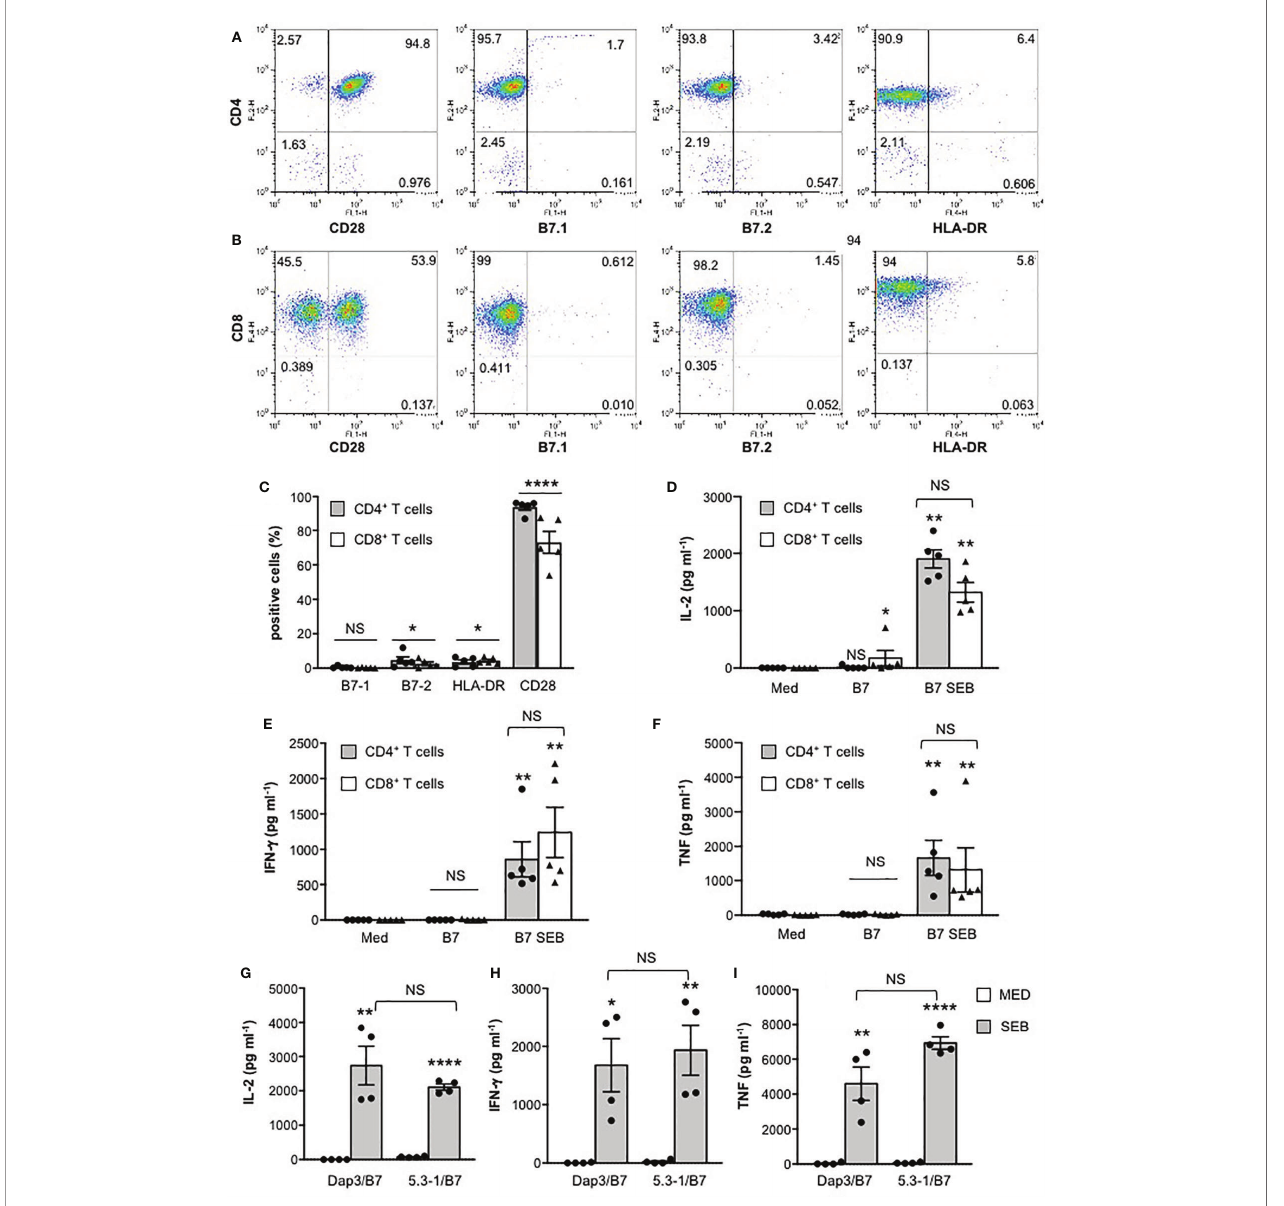
FIGURE 3 | MHC class II molecules are dispensable for SEB-induced in fl ammatory cytokine production in human primary CD4 + and CD8 + T cells. (A, B) Human CD4 + T cells (A) or CD8 + T cells (B) were isolated from the peripheral blood of healthy donors (HD). One representative FACS analysis of human CD4 + T cells stained with anti-CD4-PE plus anti-CD28-FITC or anti-B7.1-FITC or anti-B7.2-FITC or anti-CD4-FITC plus anti-HLA-DR-APC (A) , or human CD8 + T cells stained with anti-CD8-APC plus anti-CD28-FITC, or anti-B7.1-FITC, or anti-B7.2-FITC, or anti-CD8-FITC plus anti-HLA-DR-APC (B) . Numbers within each quadrant indicate the percentage of positive cells. (C) The percentage of human CD4 + T cells or CD8 + T cells from HD (n = 5) expressing B7.1, B7.2, HLA-DR and CD28 were calculated. The results express the mean percentage of positive cells ± SEM. Statistical signi fi cance was calculated by Student ’ s t test. Mean percentage values: CD4 + , B7.1 = 0.5, B7.2 = 4.6, HLA-DR = 3.5, CD28 = 93.8; CD8 + , B7.1 = 0.2, B7.2 = 2.5, HLA-DR = 4.3, CD28 = 73. (D – I) CD4 + (D – I) or CD8 + T cells (D – F) from HD were cultured for 24 hours with medium (Med), or in the presence of Dap3/B7 cells (D – I) or 5-3.1/B7 cells (G – I) with or without 1 m g ml -1 SEB. IL-2 (D) , IFN- g (E) and TNF levels (F) in culture supernatants were measured by ELISA. Data show the mean ± SEM. Statistical signi fi cance was calculated by the Mann-Whitney test. Mean values: (D – F) (n = 5) IL-2 CD4 + , Med = 0.5 pg ml -1 , B7 = 12.7 pg ml -1 , B7 SEB = 1902 pg ml -1 ; IL-2 CD8 + , Med = 0 pg ml -1 , B7 = 173.4 pg ml -1 , B7 SEB = 1320 pg ml -1 ; IFN- g CD4 + , Med = 0 pg ml -1 , B7 = 0 pg ml -1 , B7 SEB = 858.4 pg ml -1 ; IFN- g CD8 + , Med = 0 pg ml -1 , B7 = 4.9 pg ml -1 , B7 SEB = 1240 pg ml -1 ; TNF CD4 + , Med = 24.8 pg ml -1 , B7 = 19.4 pg ml -1 , B7 SEB = 1664 pg ml -1 ; TNF CD8 + , Med = 5.2 pg ml -1 , B7 = 19.4 pg ml -1 , B7 SEB = 1315 pg ml -1 ; (G – I) CD4 + T cells (n = 4), IL-2, Med = 0 pg ml -1 , Dap3/B7 = 0 pg ml -1 , Dap3/B7 SEB = 6036 pg ml -1 , 5-3.1/B7 = 4.04 pg ml -1 , 5-3.1/B7 SEB = 1006; IFN-g, Med = 1.1 pg ml -1 , Dap3/B7 = 3.7 pg ml -1 , Dap3/B7 SEB = 1676 pg ml -1 , 5-3.1/B7 = 21.2 pg ml -1 , 5-3.1/B7 SEB = 1935; TNF, Med = 8.9 pg ml -1 , Dap3/B7 = 32.8 pg ml -1 , Dap3/B7 SEB = 4592 pg ml -1 , 5-3.1/B7 = 66.5 pg ml -1 , 5-3.1/B7 SEB = 6920. (*) p < 0.05, (**) p < 0.01, (****) p < 0.0001. NS, not signi fi